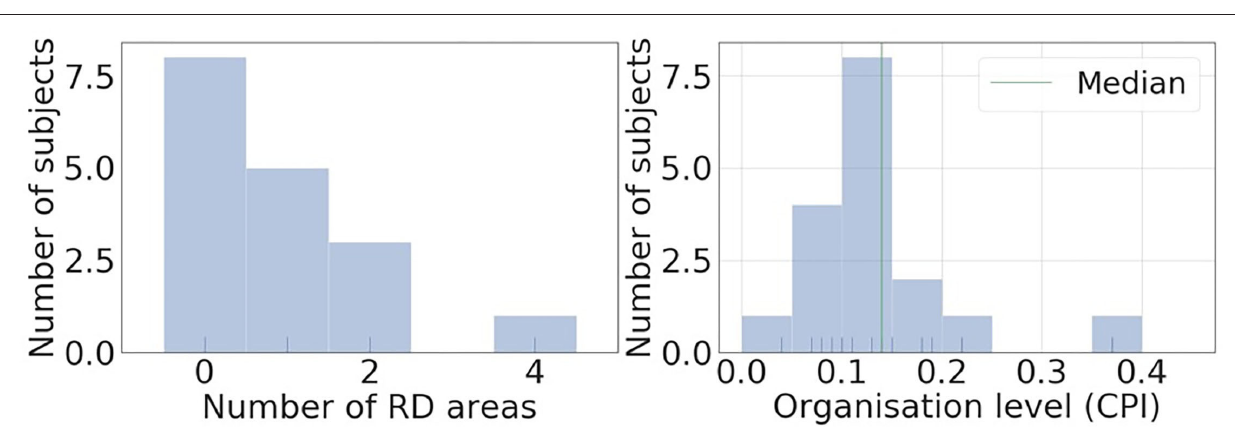
with a high CIV driving a globally organised form of